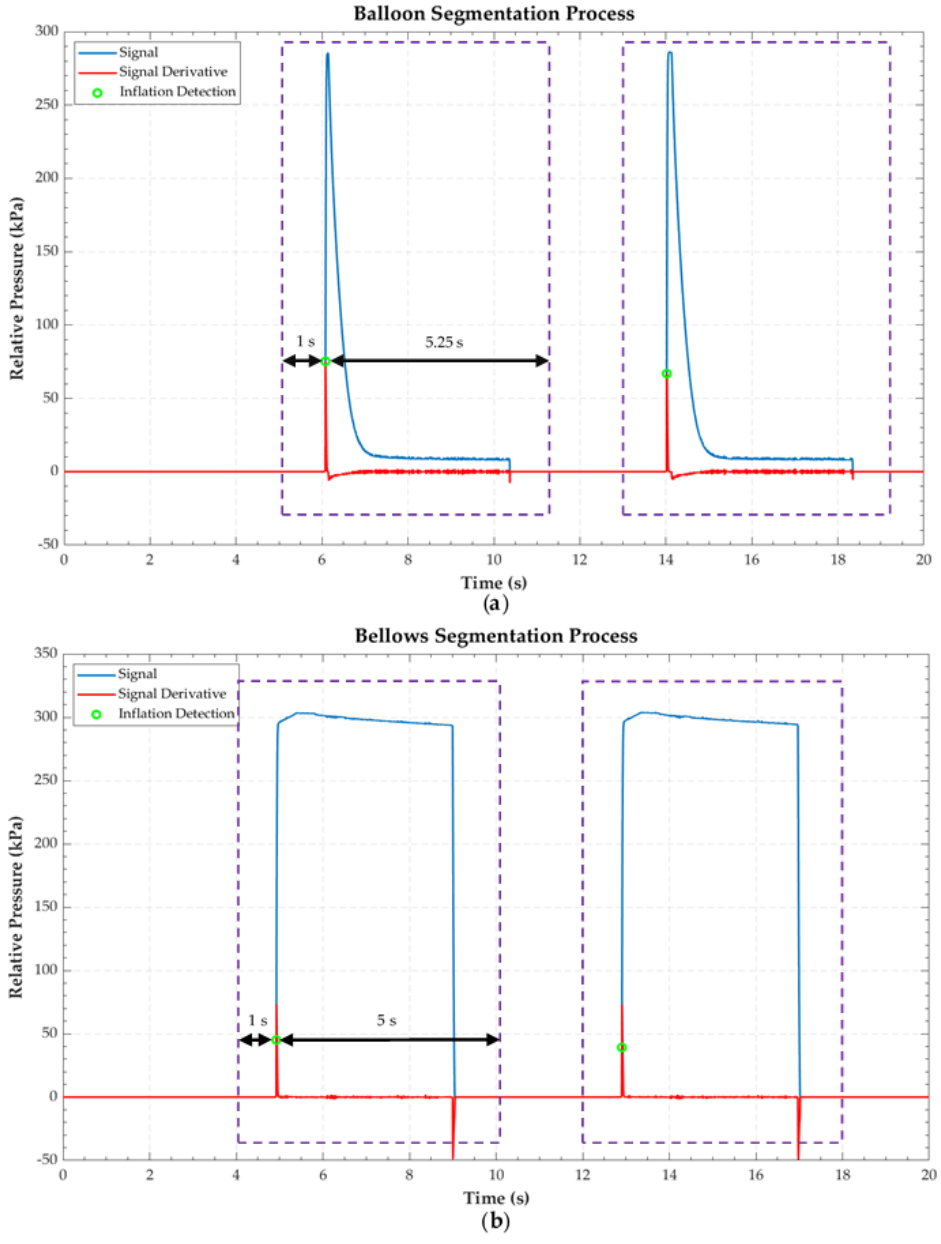
Figure 3. Graphical overview of the segmentation process of the two different Endoworm cavities: ( a ) balloon-type and ( b ) bellows-type . Dashed purple linear windows correspond to the segmented signal.